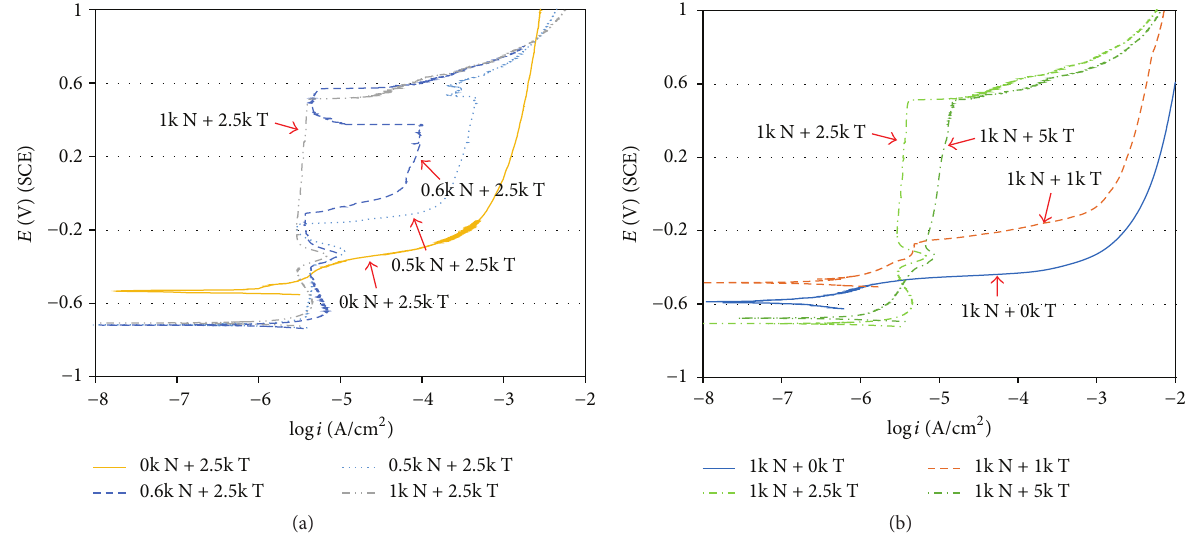
Figure 3: Effect of coadded corrosion inhibitors on anodic polarization curve of DCI (25 ∘ C deaerated tap water + x ppm corrosion inhibitor (N: NO 2− , T: TEA)). (a) 2.5k ppm T + x ppm N, (b) x ppm T + 1k ppm